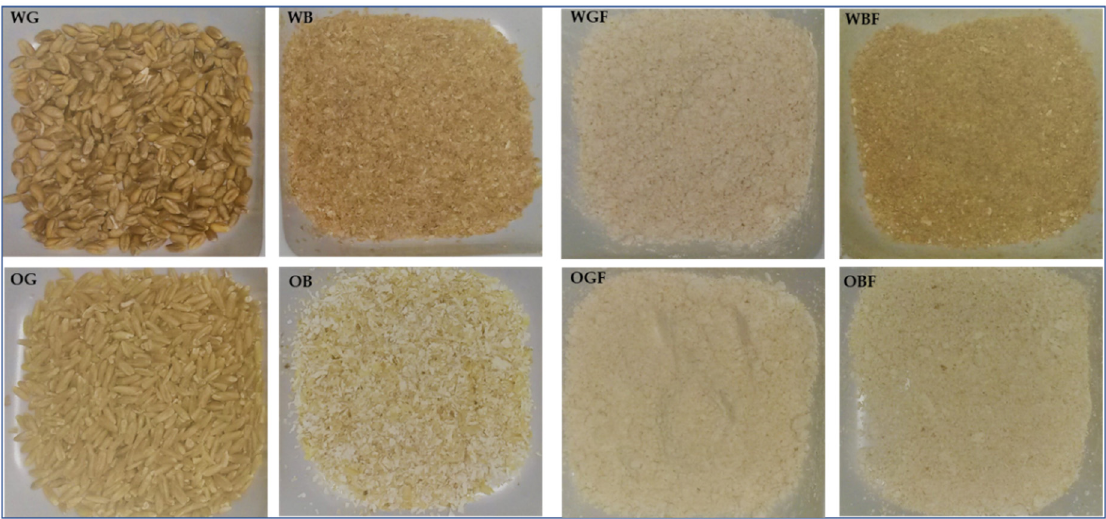
Figure 1. Raw material used for analysis. Wheat grain (WG), wheat bran (WB), oat grain (OG) and oat bran (OB) and the flours milled for all the samples: Wheat grain flour (WGF), wheat bran flour (WBF), oat grain flour (OGF), and oat bran flour (OBF).